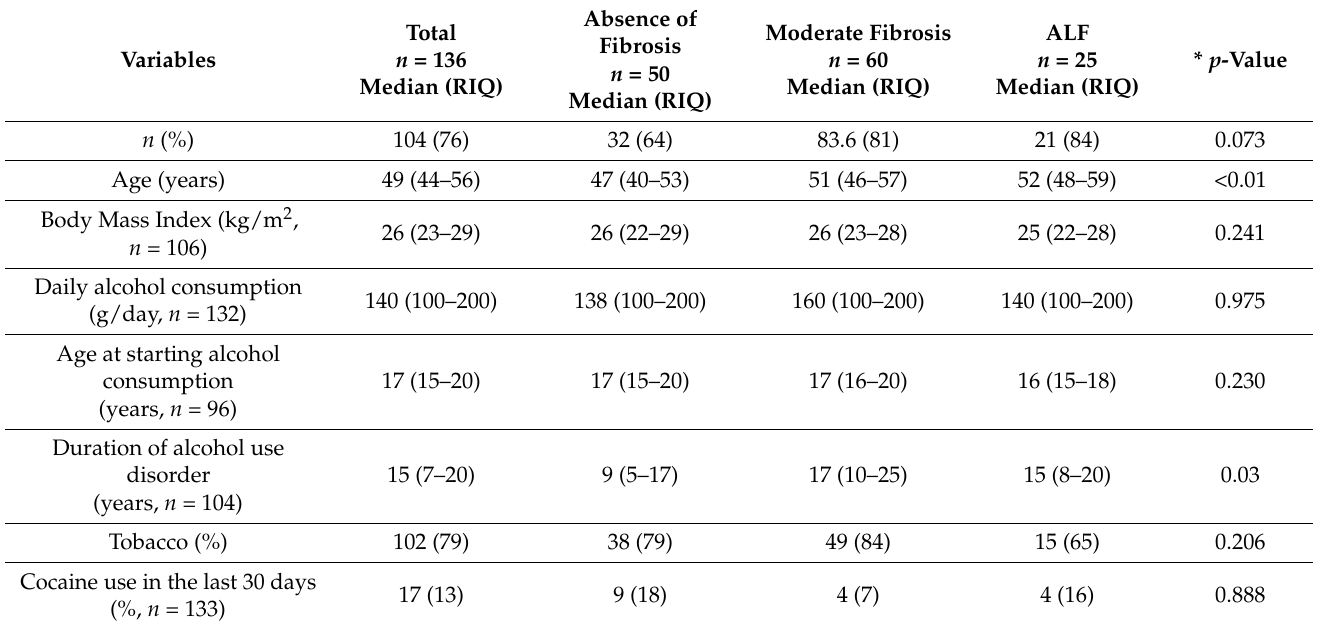
Table 1. Sociodemographic and substance use characteristics in 136 patients with alcohol use disor- ders (AUD) according to the degree of liver fibrosis (LF).